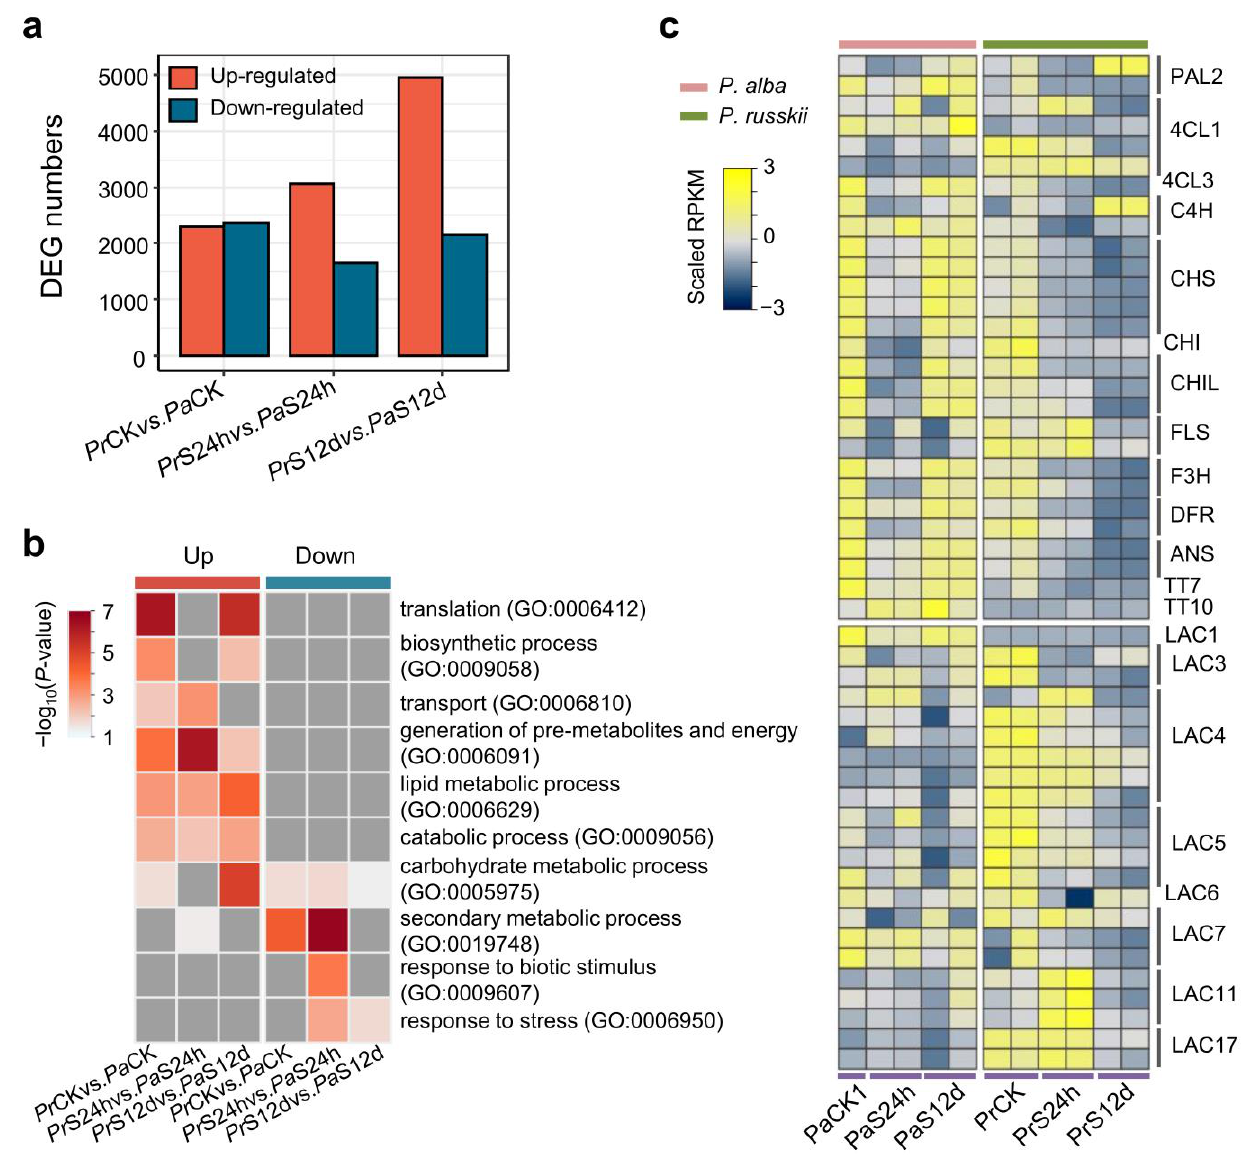
Figure 5. DEGs identified between P. alba and P. russkii . ( a ) The numbers of DEGs identified between the two Populus roots. ( b ) GO enrichment of the up-regulated or downregulated genes between the two Populus . ( c ) Heatmap showing the differential expression patterns of the genes in phenylpropanoid pathway and Laccases encoding genes between two Populus .